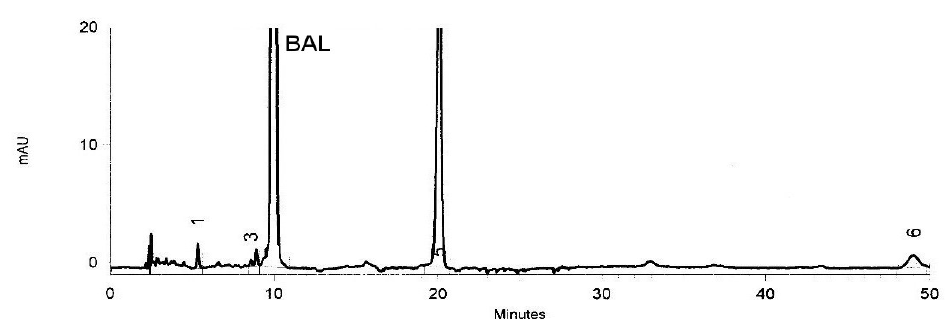
Figure 4. Chromatogram of BAL after oxidation by ACVA at 60 °C. Incubation time—48 h.